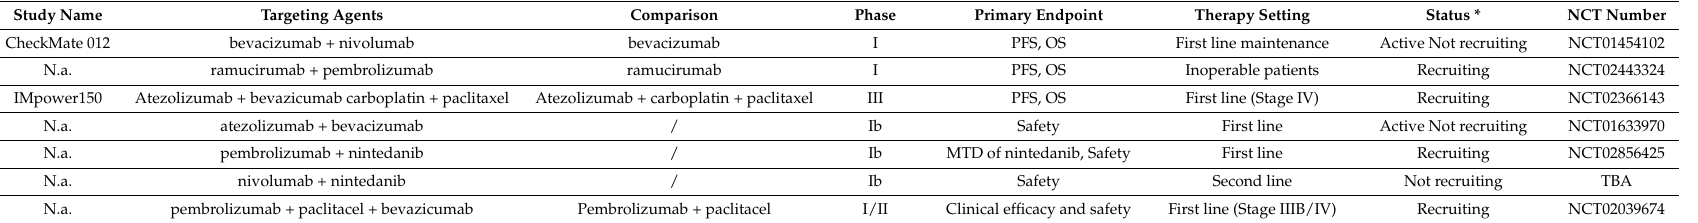
Table 2. Ongoing clinical studies combining AA and immunotherapies in